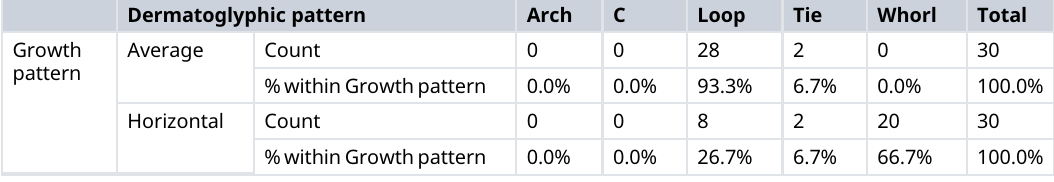
18F1000Research 2022, 11:597 Last updated: 15 NOV